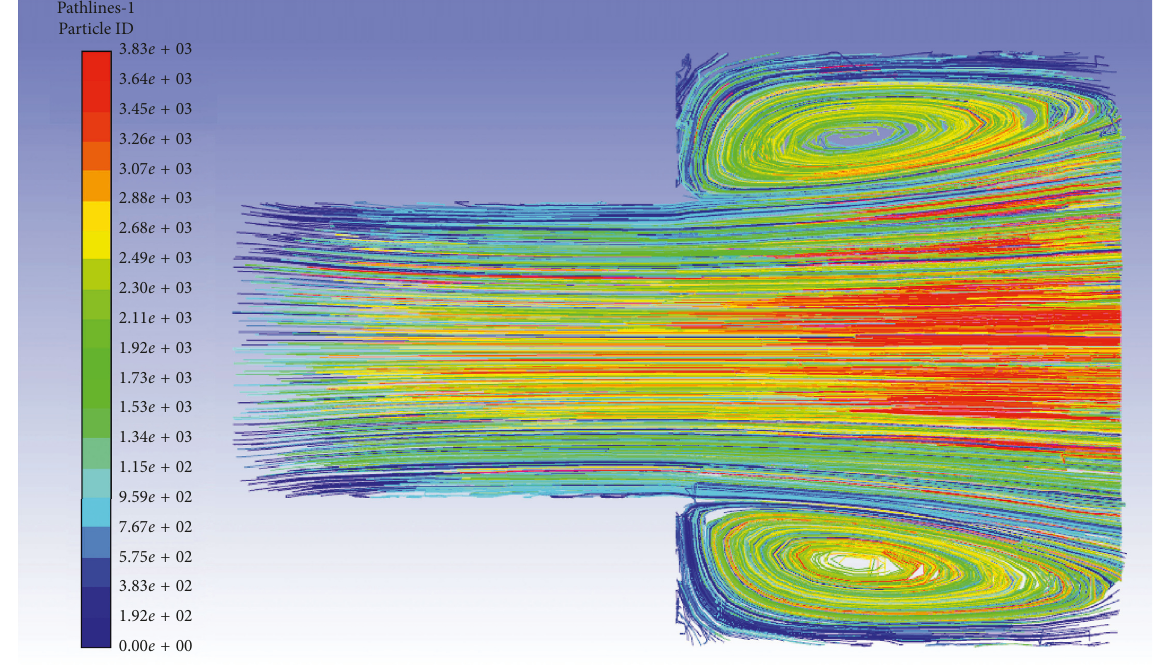
Figure 11: Sudden extension ratio is 2.